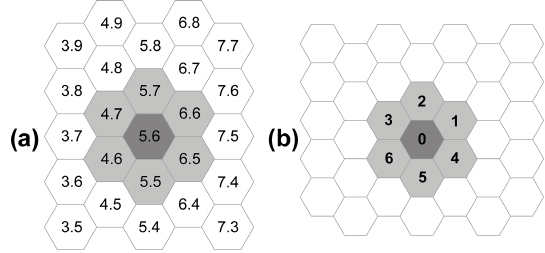
Figure 3. (a) The neighborhood of cell (5, 6); (b) neighborhood indices. Table 1. Physical and empirical